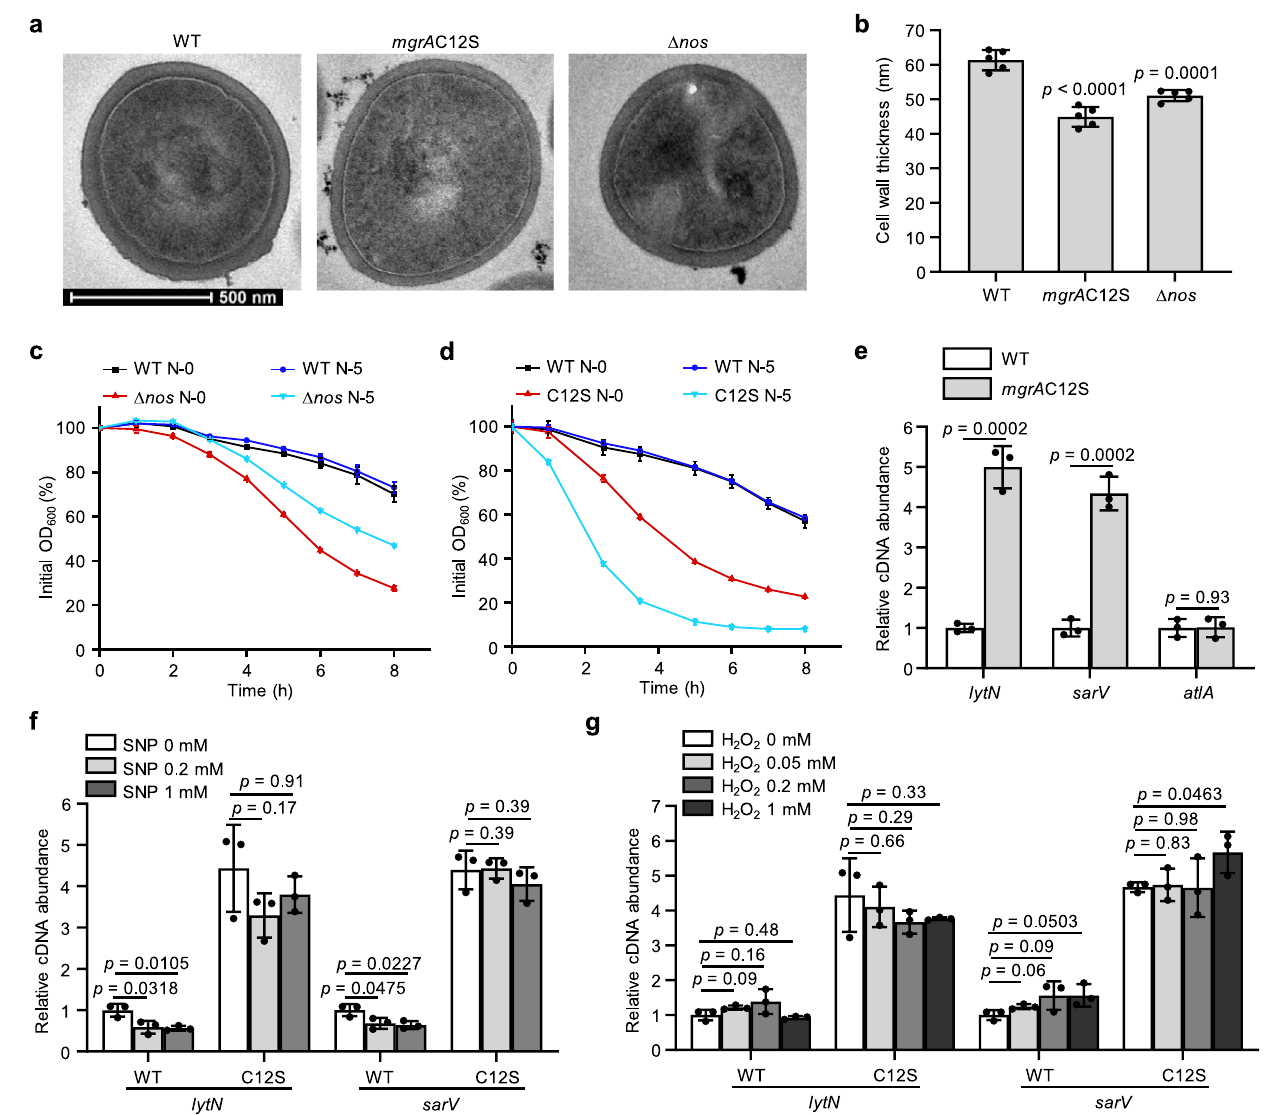
Fig. 4 | Redox-signal transduction by MgrA to vancomycin resistance is achieved by regulating cell wall thickness and cell autolysis. a , b Cell wall thickness was measured by transmission electron microscopy (TEM). Representa- tive TEM images of the WT, mgrA C12S and Δ nos strains cultured with shaking at 220rpmfor16hat37°Caredisplayed( a ).Scalebar=500nm.Cellwallthicknessof n =5 individual cells from each strain were measured three times randomly and expressedasmeanswithSD( b ).TritonX-100-inducedautolysisoftheWTand Δ nos strains ( c ) or the WT and mgrA C12S strains ( d ) was measured in Tri-HCl buffer supplemented with or without 5 μ M SNP(displayedasN-5 or N-0).The percentage